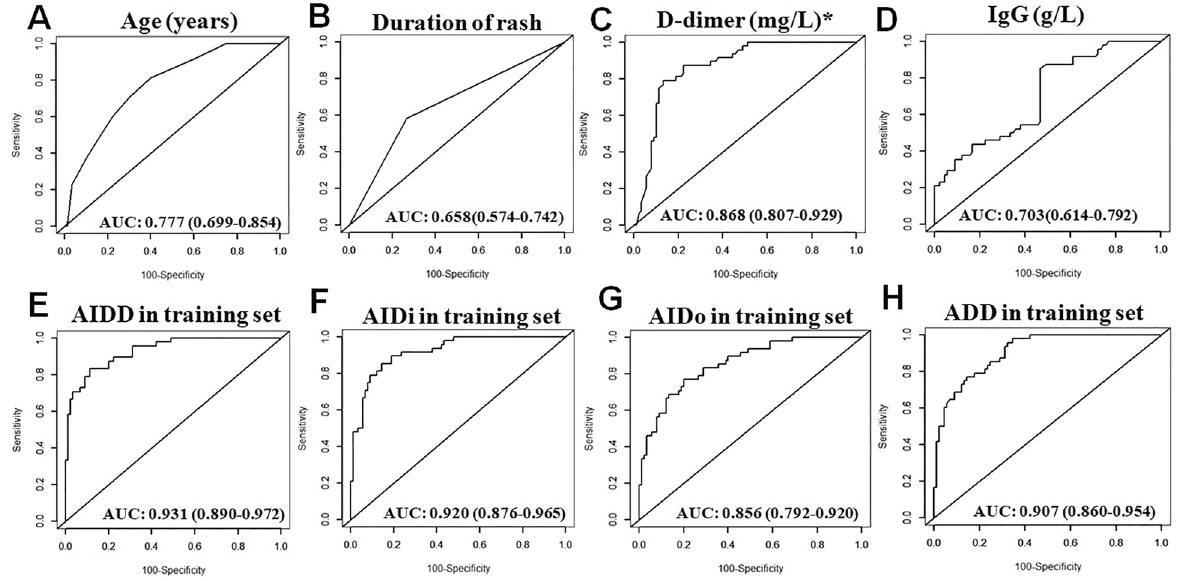
Figure 1. Receiver operating characteristic curve analysis of 4 independent risk factors and 4 combined models for predicting the risk of IgA vasculitis nephritis in training set. AUROC of the age ( A ), duration of rash ( B ), D-dimer ( C ), IgG ( D ), AIDD ( E ), AIDi ( F ), AIDo ( G ) and ADD ( H ). *Based on the square root of the D-dimer